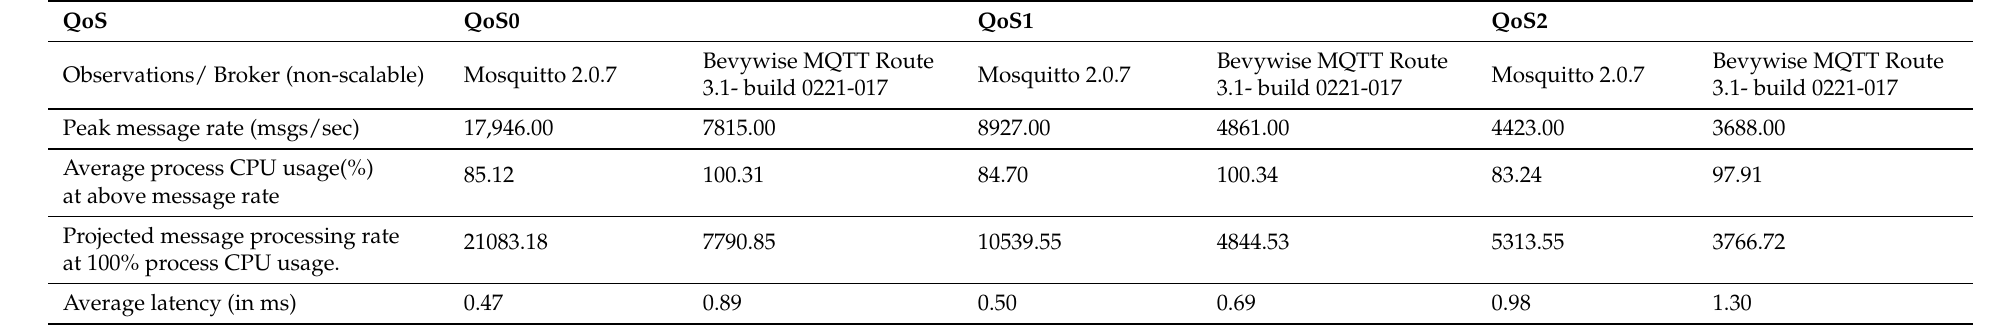
Table 7. Projected message processing rates of non-scalable brokers at 100% process CPU usage (cloud test results). Mosquitto and Bevywise are fixed thread/single thread broker implementations. They cannot scale up to use all the cores available in the